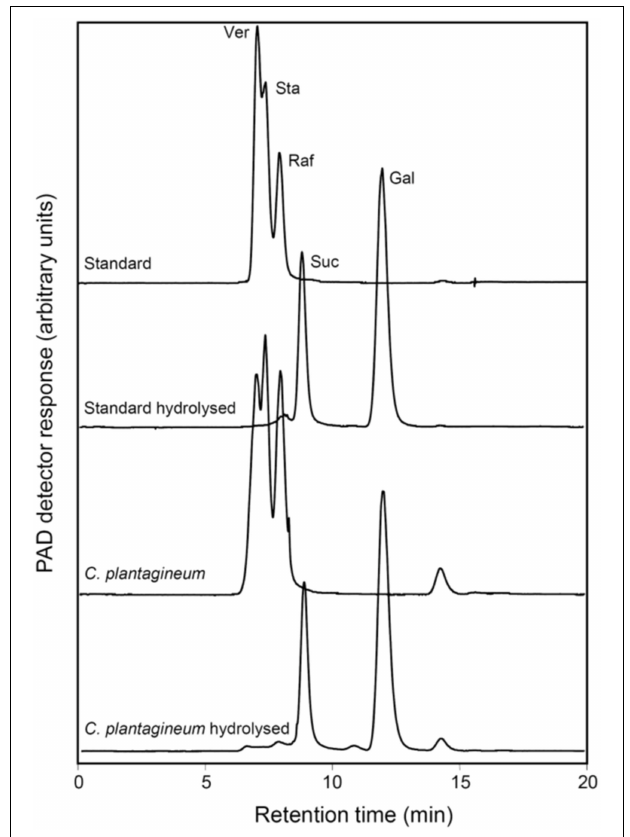
FIGURE 3 | HPLC-PAD chromatograms representing the identification of the oligosaccharides formed in leaves of water deficit-stressed C. plantagineum plants (collected at 5% RWC). The oligosaccharides were collected, enzymatically hydrolyzed with a commercial alkaline α -galactosidase from A. niger and compared with a Ver, Sta, and Raf standard (2mg ml − 1 each) treated the same way. Ver, verbascose; Sta, stachyose; Raf, raffinose; Suc, sucrose; Gal, galactose.